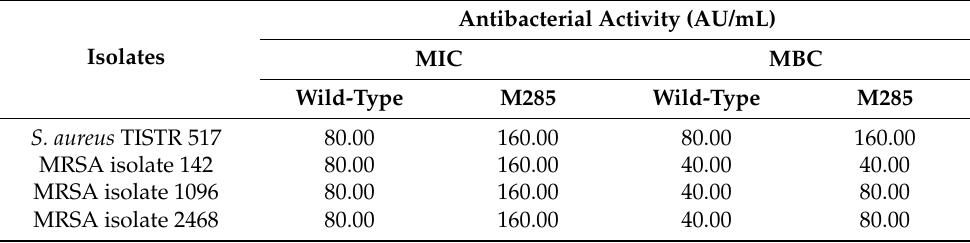
Table 3. Susceptibility testing of S. aureus TISTR 517 and its resistant strains (MRSA) to